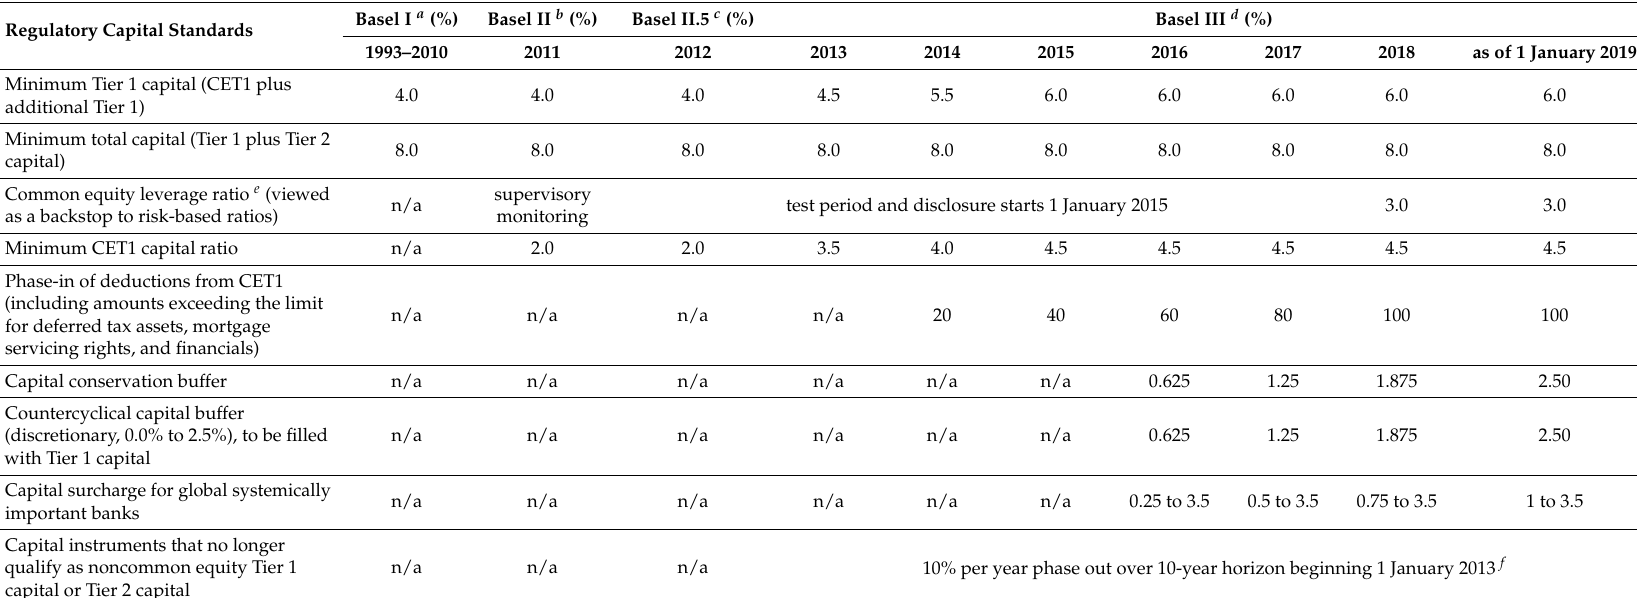
Table 1. A Timeline of Basel Capital